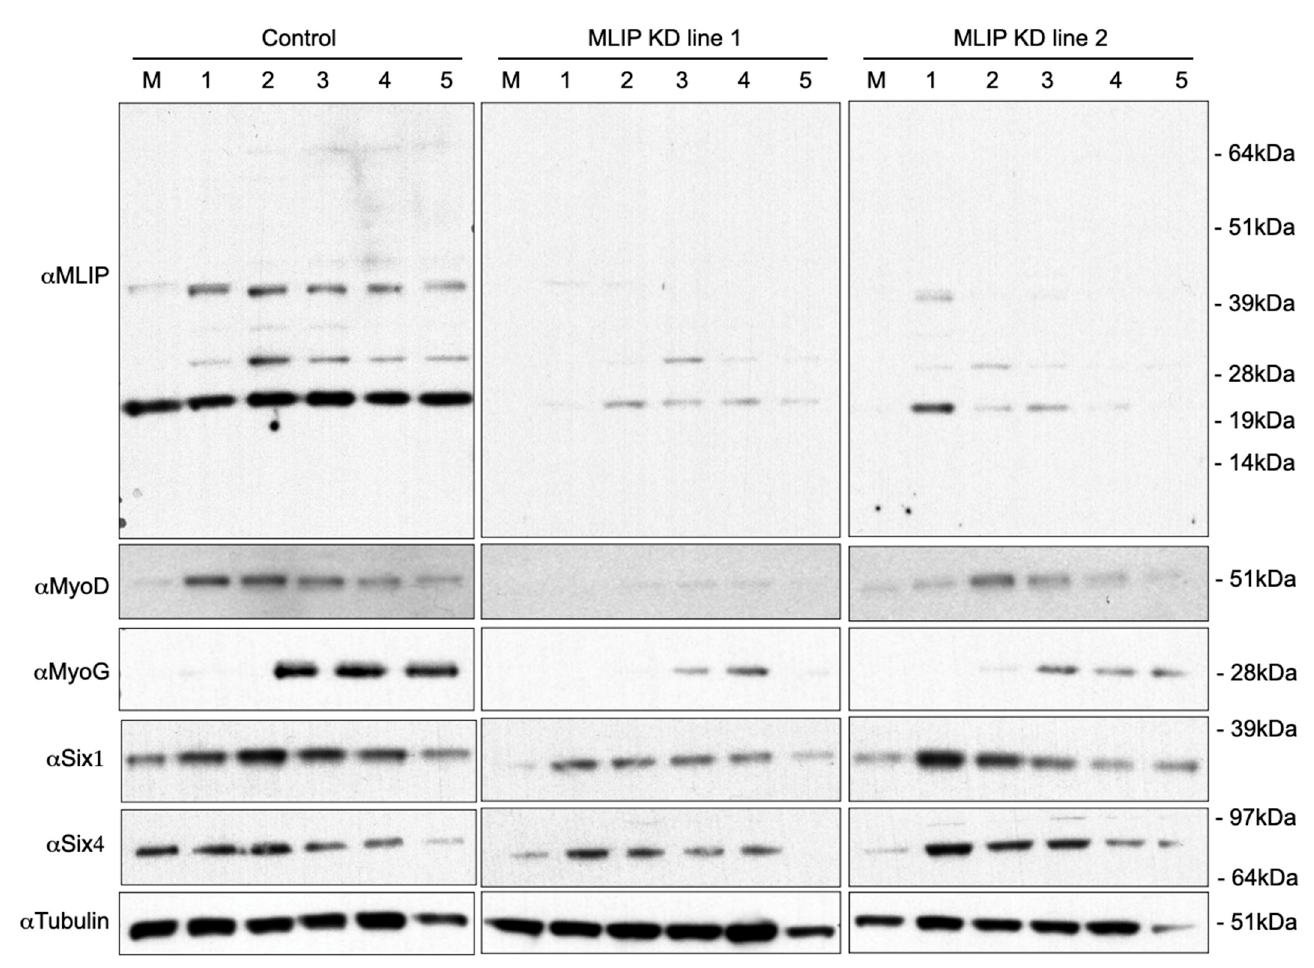
Figure 3. Mlip is necessary for C2C12 myoblast differentiation into myotubes. Western Blot analysis of C2C12 myoblasts (M) and C2C12 cells grown in differentiation media was performed using anti- Mlip , anti-MyoD, anti-MyoG, anti-Six1 and anti-SIX4 polyclonal antibodies. Lysates were isolated every day for 5 days of differentiation. Control cells were generated using a validated non-silencing negative control.